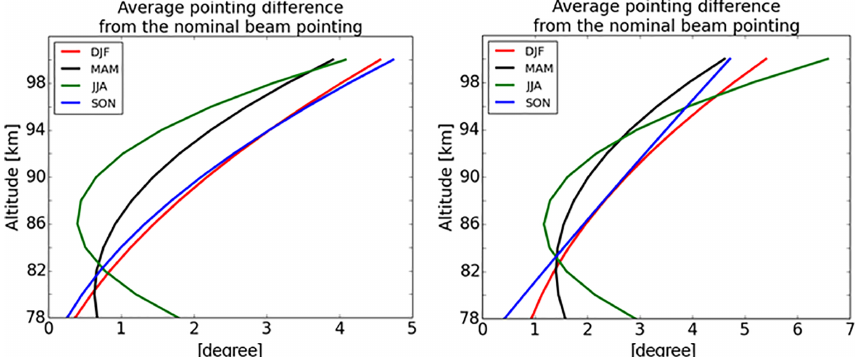
Figure 13. Theoretical average pointing difference from the nominal beam pointing of the Saura radar for DJF (red), MAM (black), JJA (green), and SON (blue) for the years 2004–2014. The left panel shows the zonal wind component, and the right panel shows the meridional wind